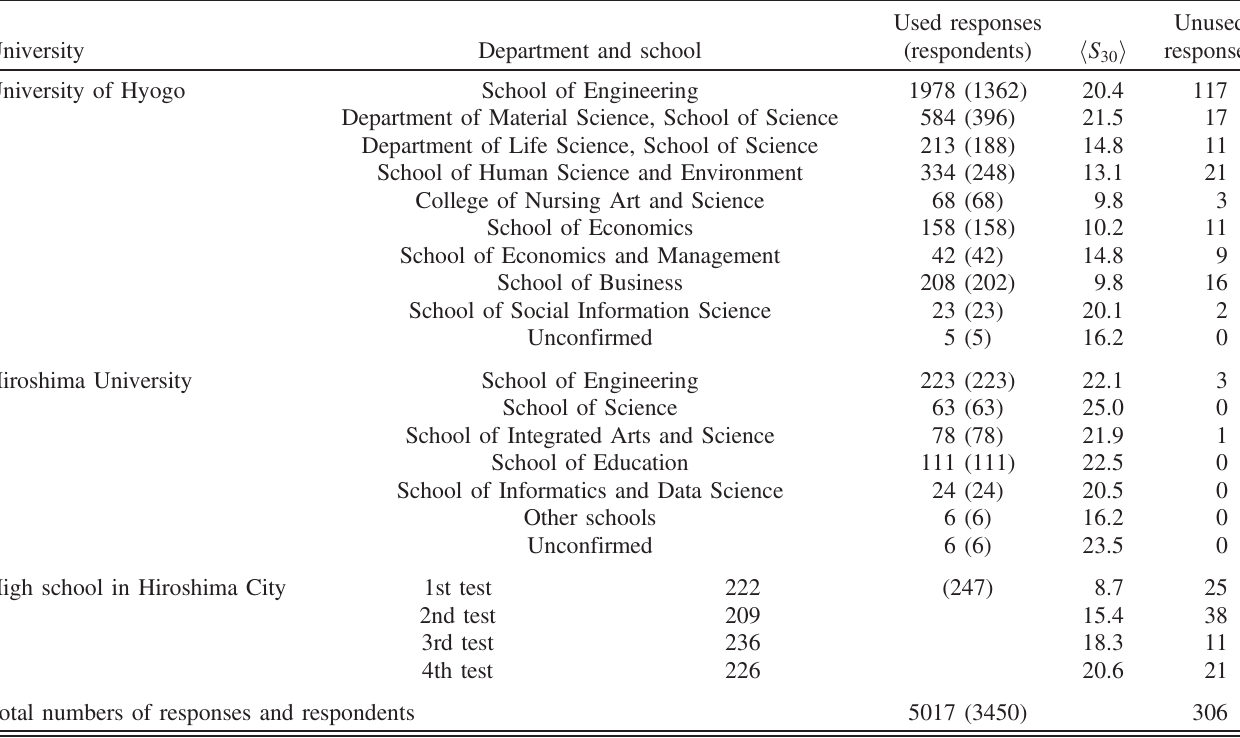
TABLE I. Affiliations of respondents and number of test results. h S 30 i is a group average of S 30 . University